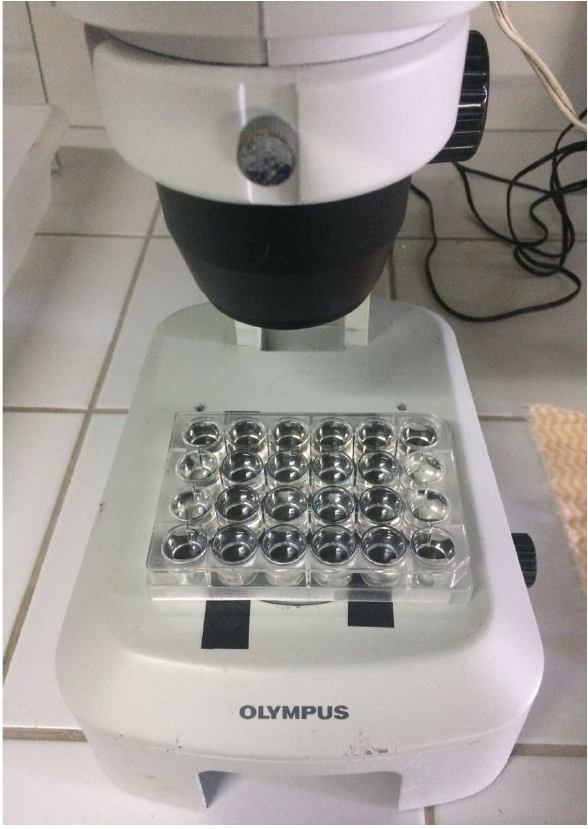
Figure 1. Leptuca leptodactyla . Inspection of the presence of exuviae and counting of dead larvae under stereomicroscope. Each well contained one